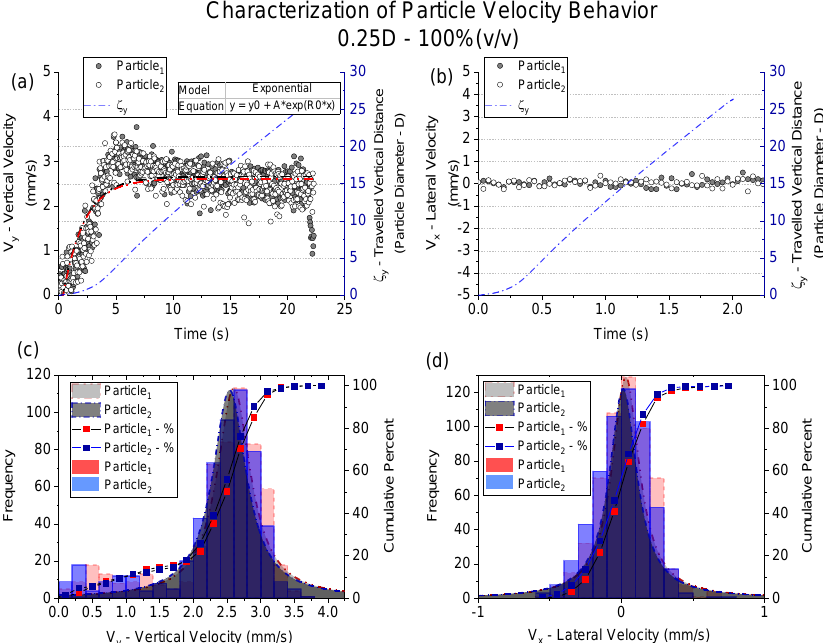
Figure 9. Plots representing an example of particles’ velocity components: ( a ) vertical and ( b ) lateral for 0.25D – 25%( v/v ) and their associated histogram distributions ( c , d ). Prominent repulsion is appar- ent in lateral velocity components.